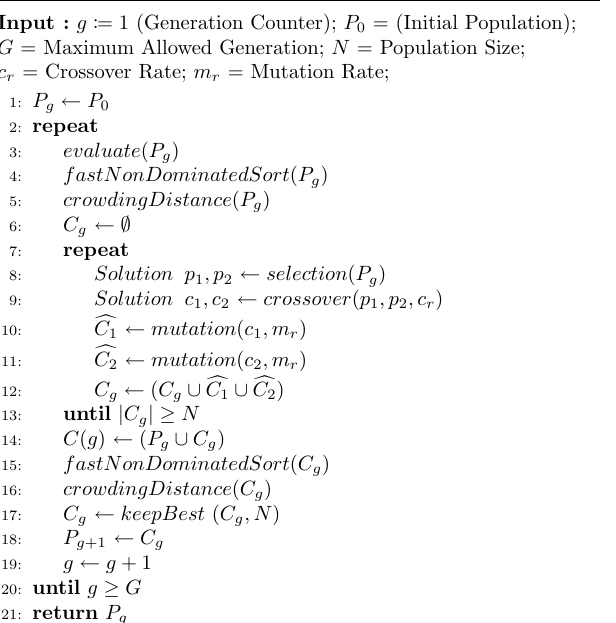
Algorithm 3 Phase2: General